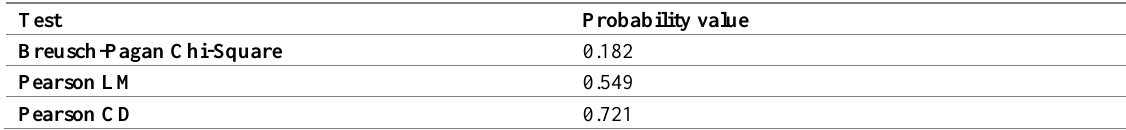
Table 4: Cross-sectional Dependency